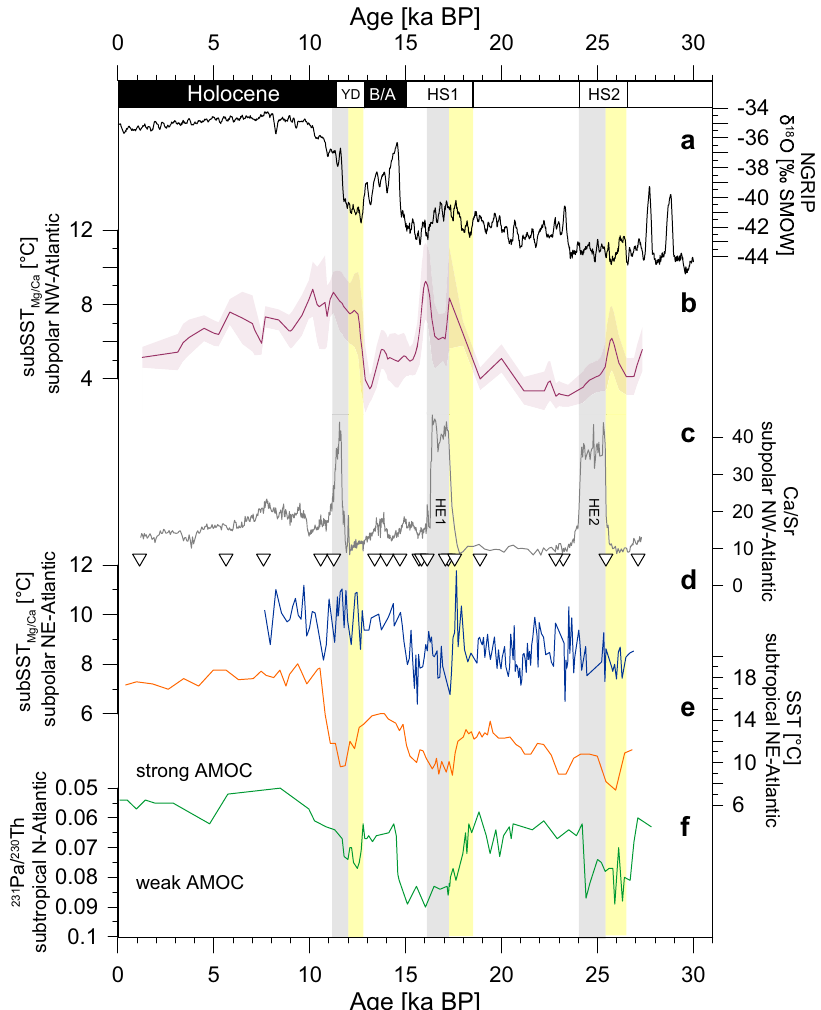
Fig. 4 Comparison of proxy records from sediment core GeoB18530-1 to representative Greenland – North Atlantic proxy records over the last 27,000 years. a North Greenland Ice Core Project (NGRIP) 22,23 stable oxygen isotopic composition ( δ 18 O) re fl ecting atmospheric temperatures over Greenland. b Mean ages from age model ensemble for subsurface temperatures of core GeoB18530-1 with 95% con fi dence interval (this study). c X-ray fl uorescence scanning-derived calcium to strontium ratios (Ca/Sr) (grey line) and age control points derived from calibrated AMS 14 C ages (open triangles) from core GeoB18530-1 (this study). d Subsurface temperatures from core MD01-2461 (eastern subpolar North Atlantic) 24 . e Alkenone sea surface temperatures from core SU8118 (eastern subtropical North Atlantic) 4 . f Pa/Th ratio re fl ecting the strength of the Atlantic Meridional Overturning Circulation (AMOC). Time series from 0 to 19 ka BP derived from core OCE326-GGC5 6 , time series from 20 to 27 ka BP derived from ODP Site 1063 26 . Yellow bars = phases of increases in subSST Mg/Ca into Heinrich Events and the Younger Dryas (YD); grey bars = Heinrich Layers (HE2 Heinrich Event 2, HE1 Heinrich Event 1) and the YD. B/A Bølling – Allerød interstadial, HS Heinrich